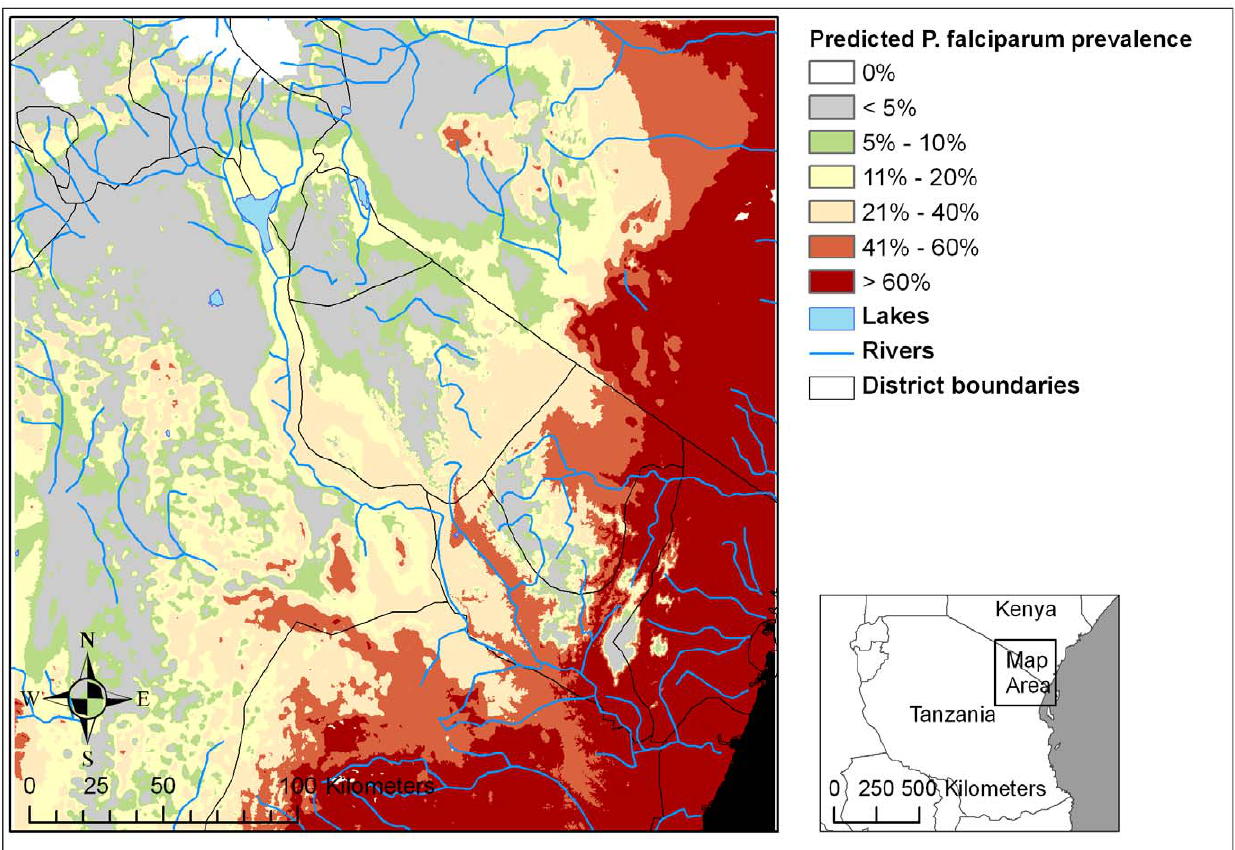
Figure 5. Categorical map of predicted malaria prevalence. Predicted P. falciparum prevalence in children 2 to 9 years old as a function of altitude and vector habitat availability within 1.5 km of grid cells (predicted from niche models) is shown on a categorical